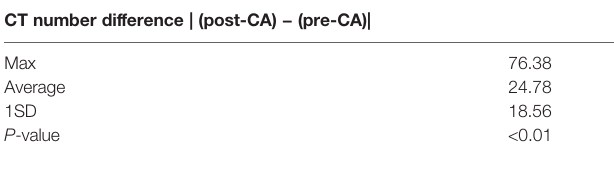
TABLE 3 | CT number difference of tumor between pre- and post-CA.